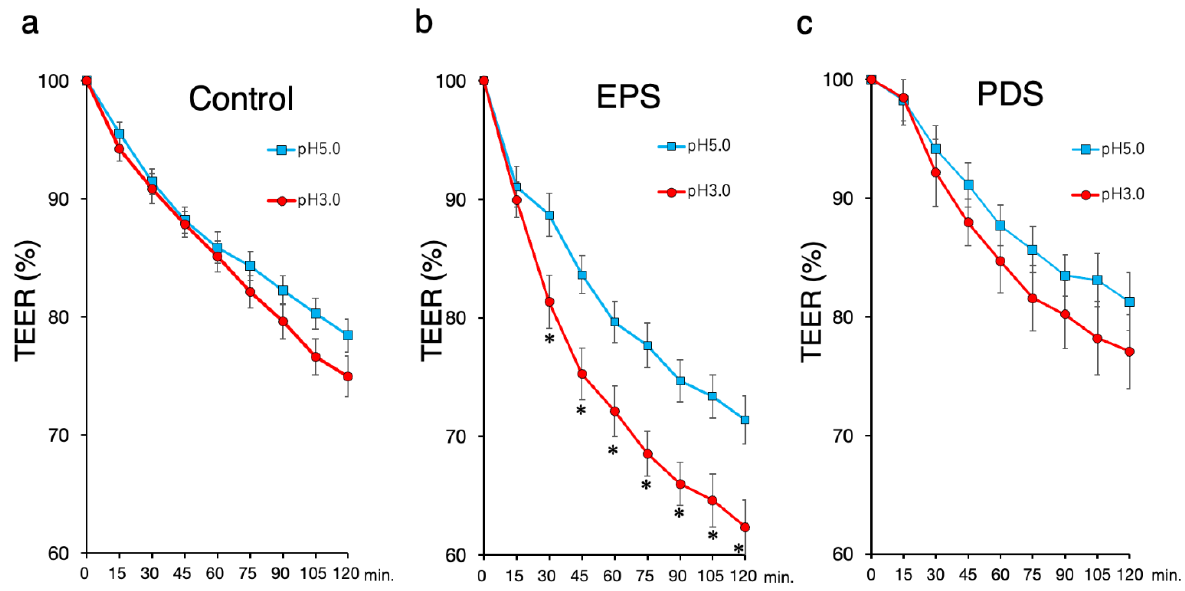
Figure 1. Transepithelial electrical resistance (TEER) in the duodenal mucosa. The exposure to a pH 3 or pH 5 acid solution was performed in each biopsy sample collected from the duodenal mucosa for 120 min during TEER measurements using a mini-Ussing chamber. Changes in the TEER are expressed as percentages relative to the initial values. Each plotted data point represents the mean ± standard deviation. ( a ) TEER in the controls ( n = 23); ( b ) TEER in the EPS patients ( n = 16); ( c ) TEER in the PDS patients ( n = 11). Closed circle: the exposure to pH3 acidic solution, open square: the exposure to pH5 acidic solution. TEER: transepithelial electrical resistance, EPS: epigastric pain syndrome, PDS: postprandial distress syndrome. * p < 0.05, significant difference at each time point using Student’s t